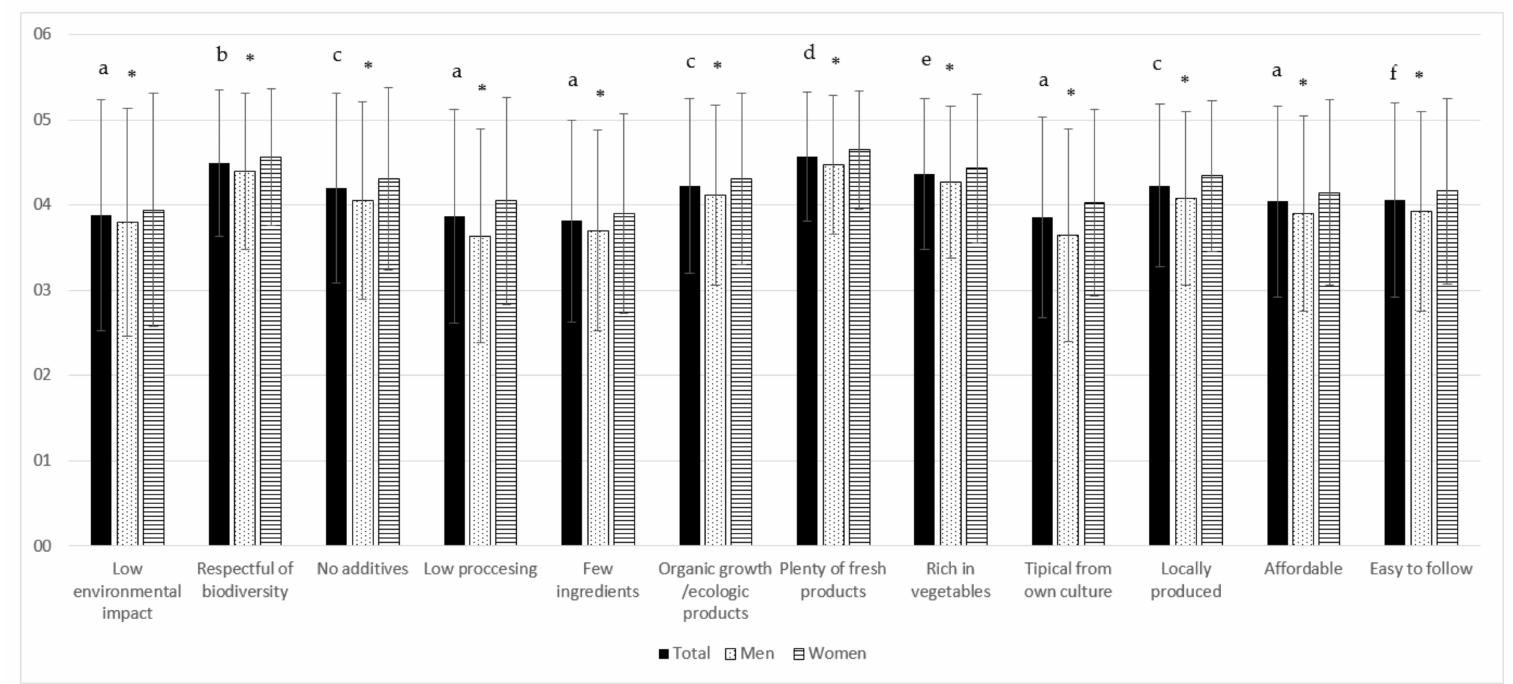
Figure 2. Perceived attributes that define a sustainable diet, in a scale 1–5 (1 = not important at all to 5 = very important) in Spanish adult population, by gender. Di ff erent letter superscripts denote statistical di ff erences ( p ≤ 0.05) between scores given to the di ff erent items; * shows statistical di ff erences ( p ≤ 0.001) between men and women in each item. Sample sizes were n = 845 men and n = 1107 women; Non respondents = 100